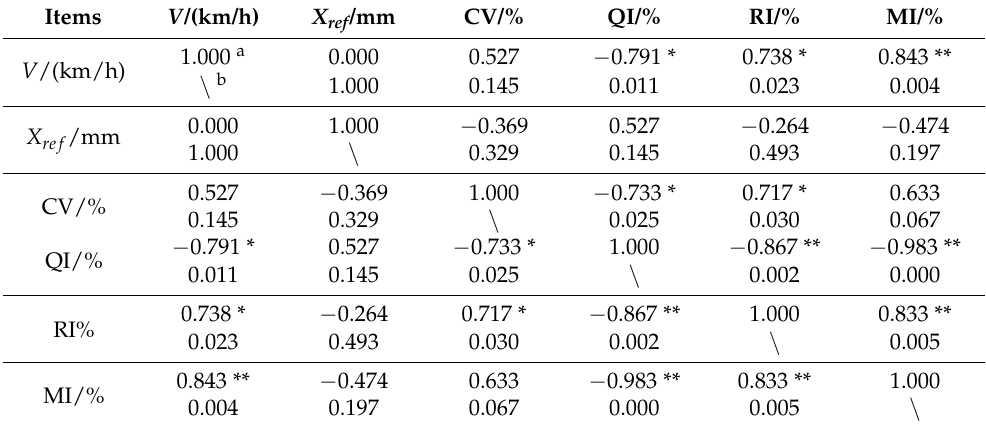
Table 4. Correlation analysis between factors and performance indicators.